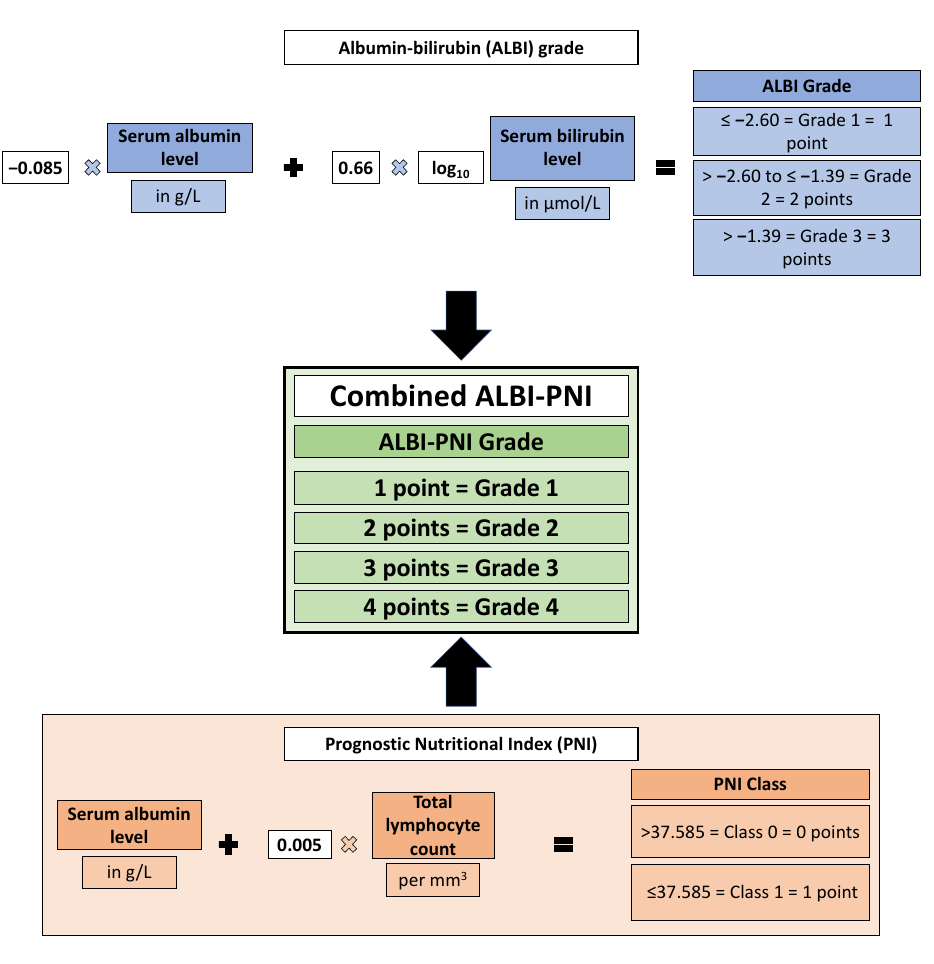
Figure 2. Overview of the formula for calculating the ALBI grade and PNI and the combination of both.